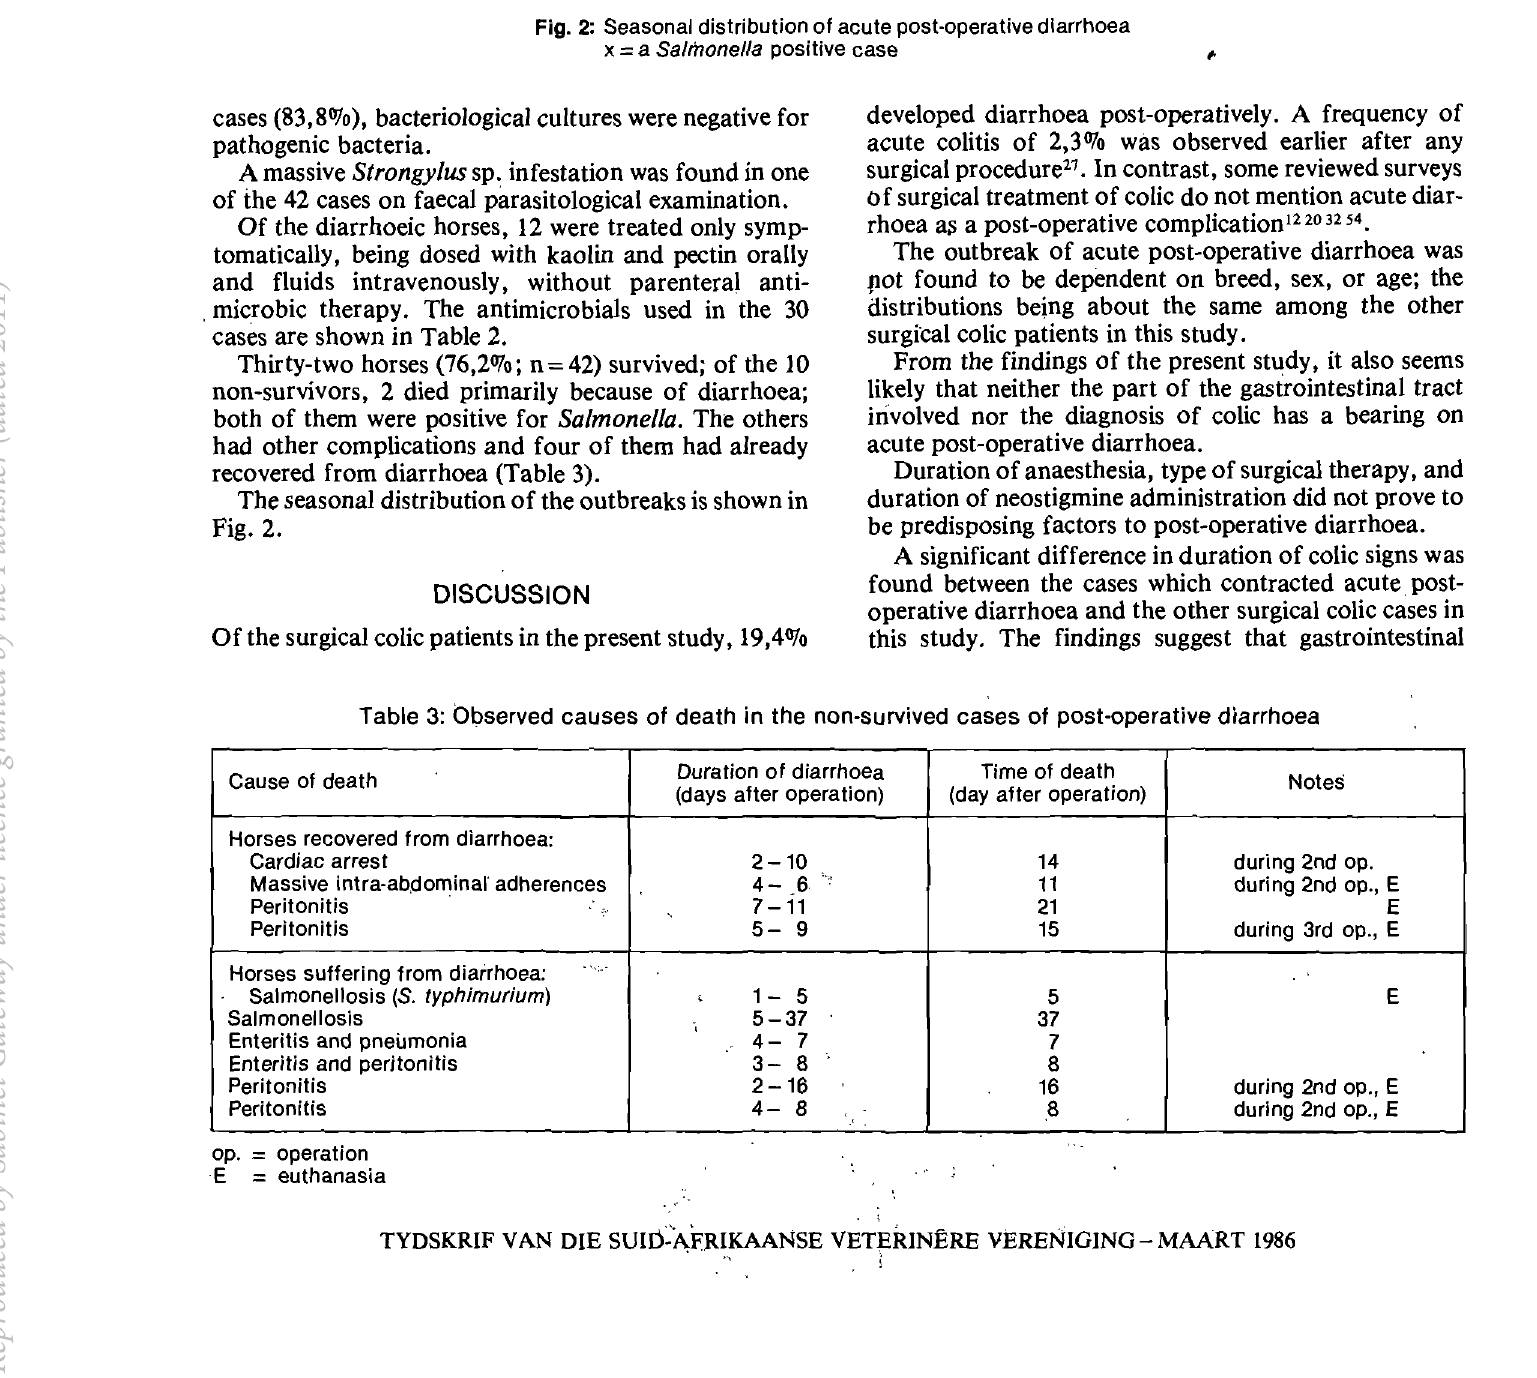
Fig. 2: Seasonal distribution of acute post·operative diarrhoea = a Salmonella positive case x